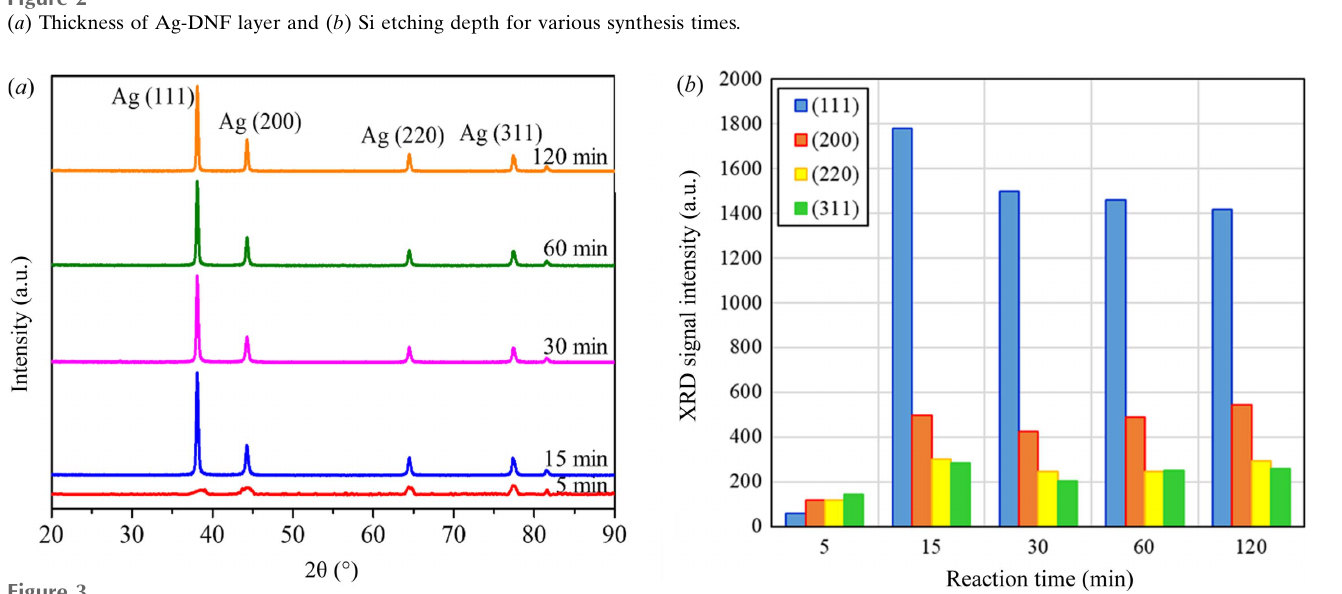
Figure 3 ( a ) XRD data of various Ag-DNF/Si samples. ( b ) XRD peak intensities of crystal faces of synthesized Ag-DNFs.